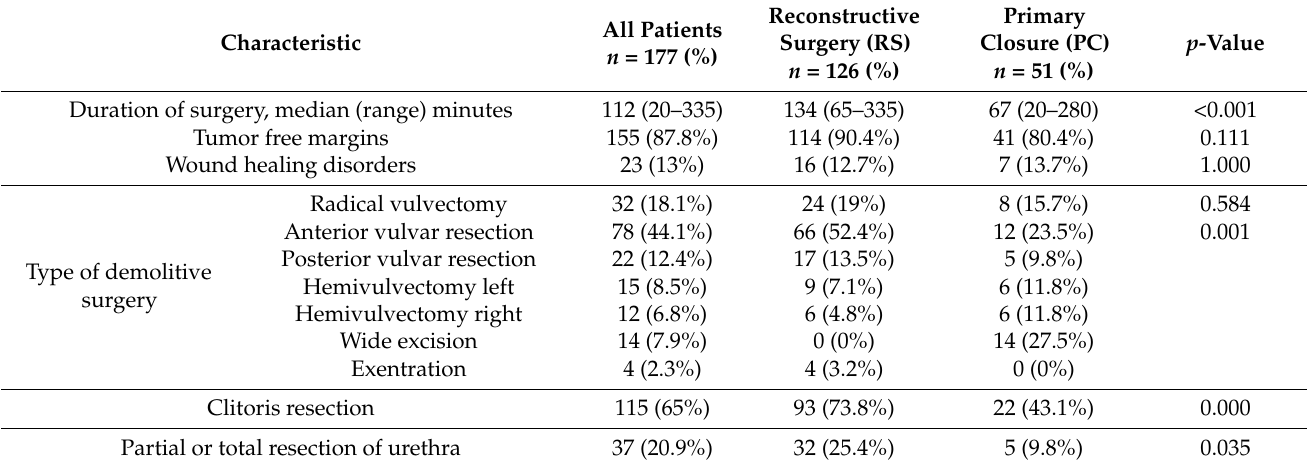
Table 2. Demolitive and reconstructive surgery